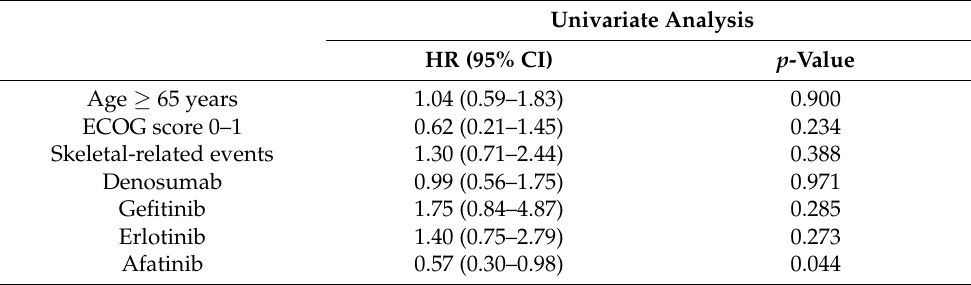
Figure 1. Progression free survival (PFS) in patients with lung adenocarcinoma and bone metastasis. ( A ) PFS in relation to ECOG score, ( B ) PFS in relation to denosumab treatment, ( C – E ) PFS in relation to first-line EGFR-TKIs. Abbreviations: PFS, progression-free survival; ECOG, Eastern Cooperative Oncology Group. Table 2. Univariate analysis for progression free survival.